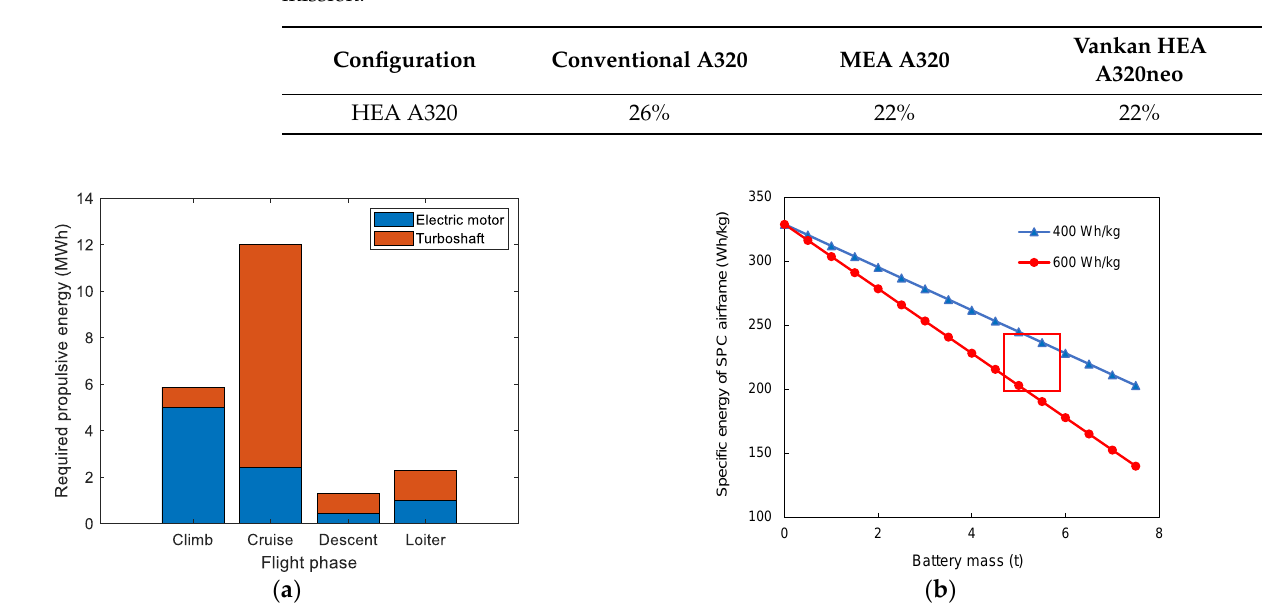
Table 8. HEA fuel efficiency improvements with conventional and electric aircraft for a 1500 km mission.